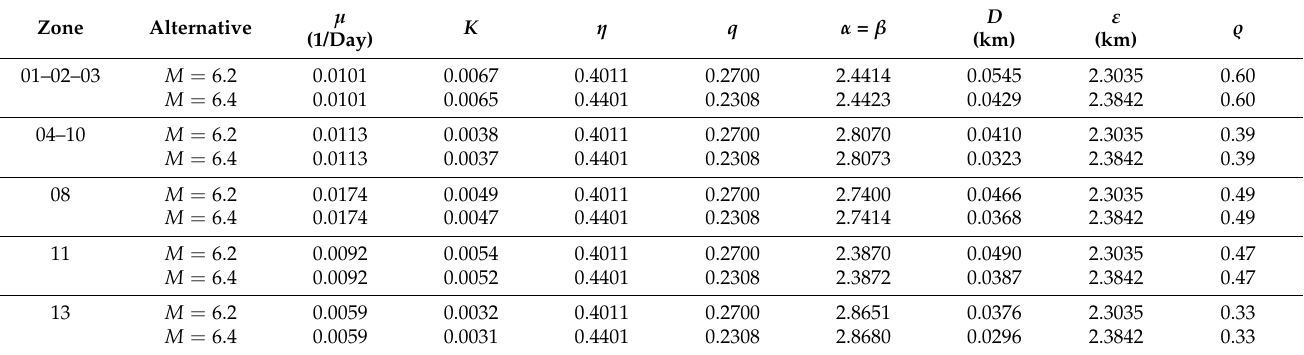
Table 5. Alternative results for the downscaled parameters, starting from two alternative parameter sets of the overall model calculated with different magnitudes of the Petrinja mainshock, M = 6.2 and M = 6.4, respectively (cf. Table